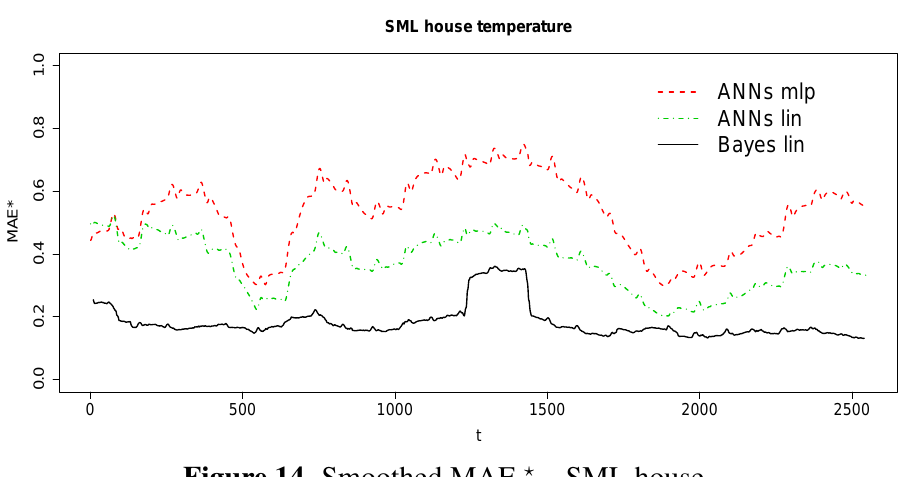
Figure 14. Smoothed MAE (cid:63) —SML